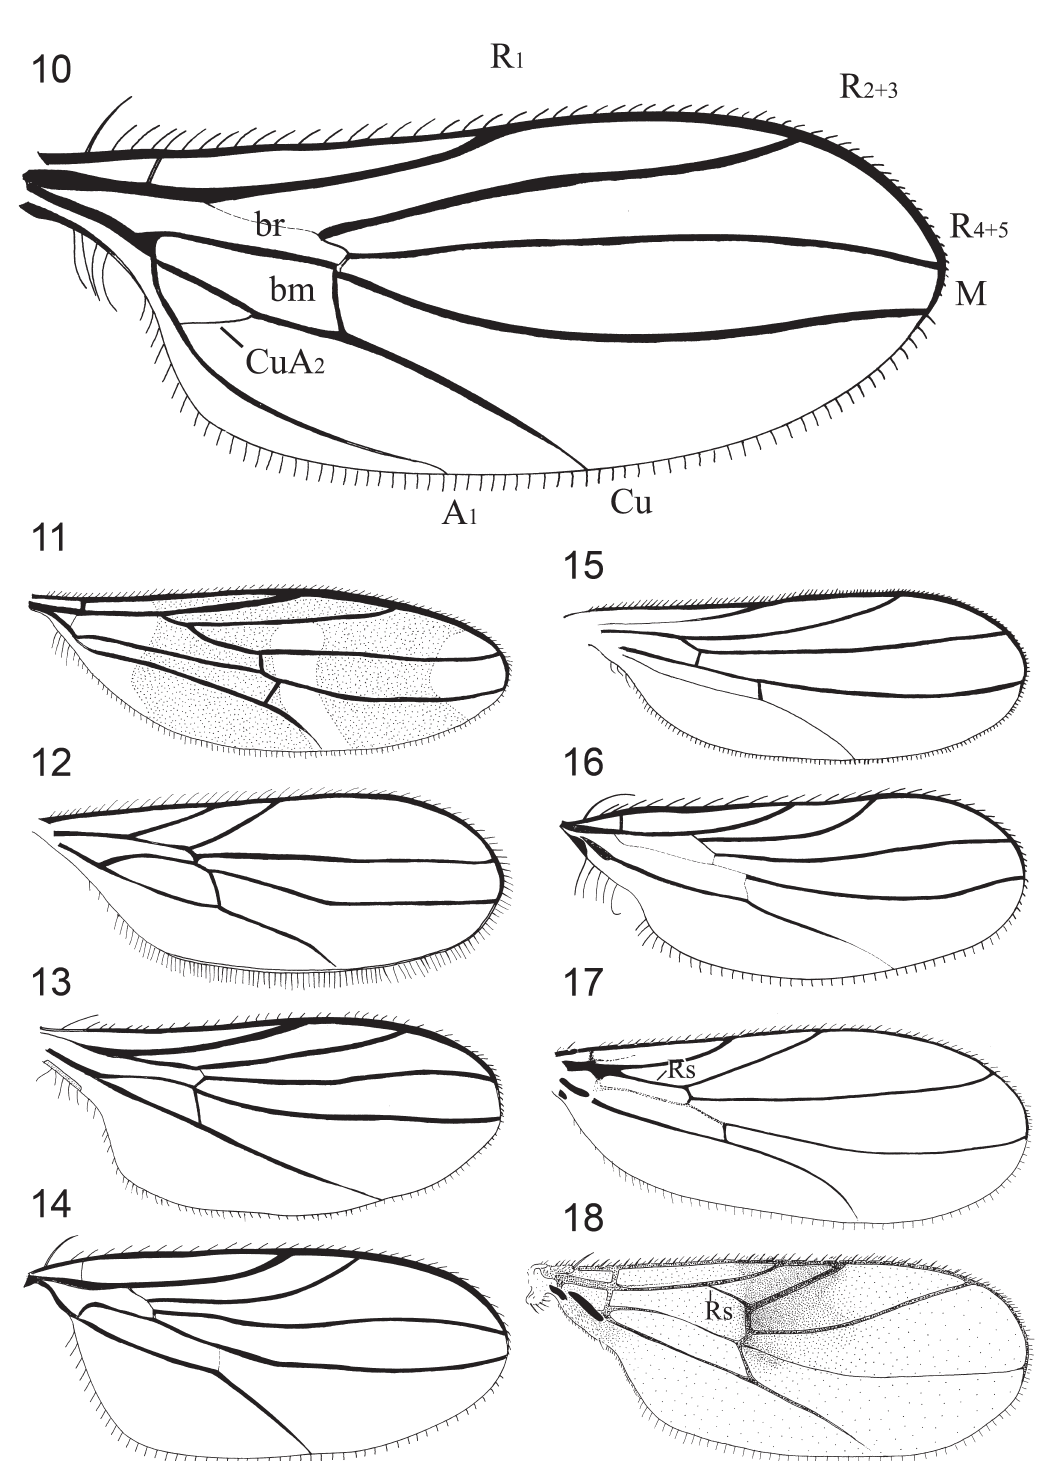
Figs 10-18. Wings of Tachydromiinae. 10 . Platypalpus singaporensis sp. nov. 11 . Tachydromia